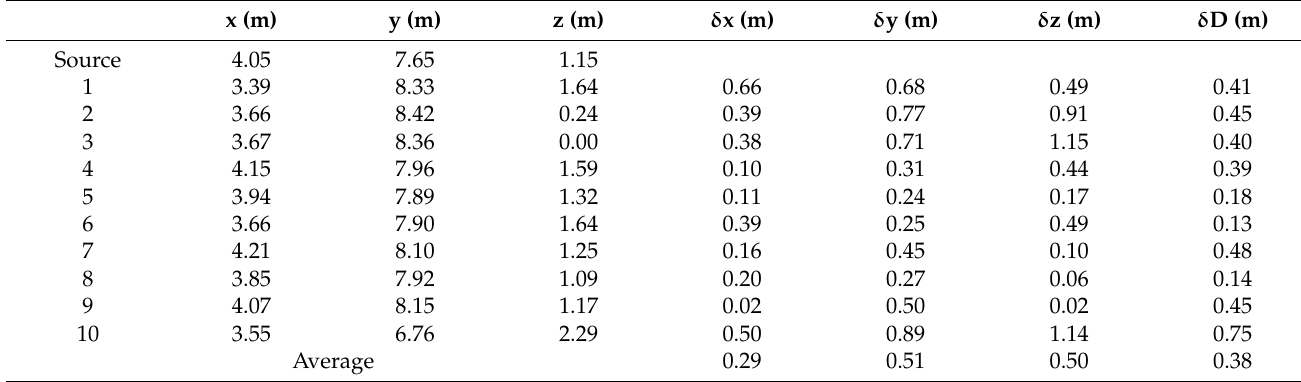
Figure 8. Preliminary tests with tetrahedral arrangements. In the right-angled pyramidal array tests, microphone 1 was used as the relative Table 3. Preliminary test results with the right-angled pyramidal arrangement. origin point, whereas microphones 2, 3, and 4 were placed at positions (0.00, 0.00, 0.00),